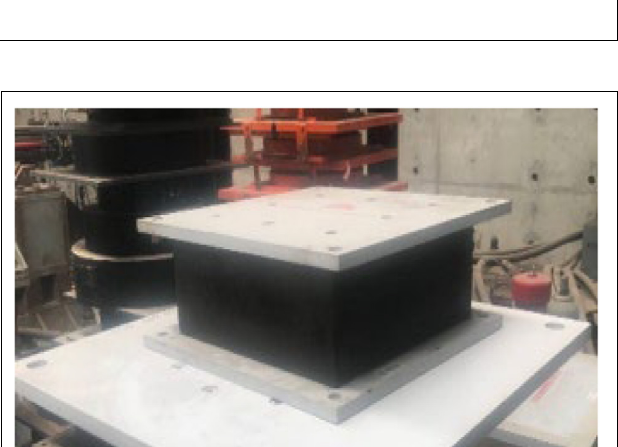
FIGURE 1 | Evaluation of the specimen.